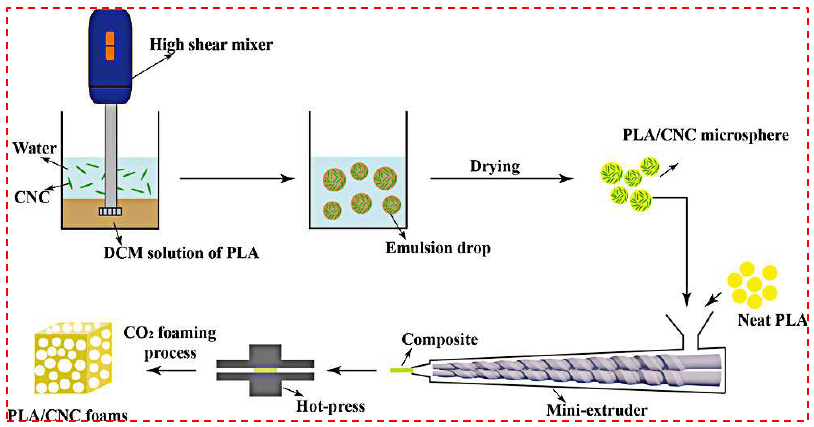
Figure 7. Principle of PLA/CNC composite films prepared by Pickering emulsion method (repro- duced with permission from Reference [69], Copyright 2021 American Chemical Society).